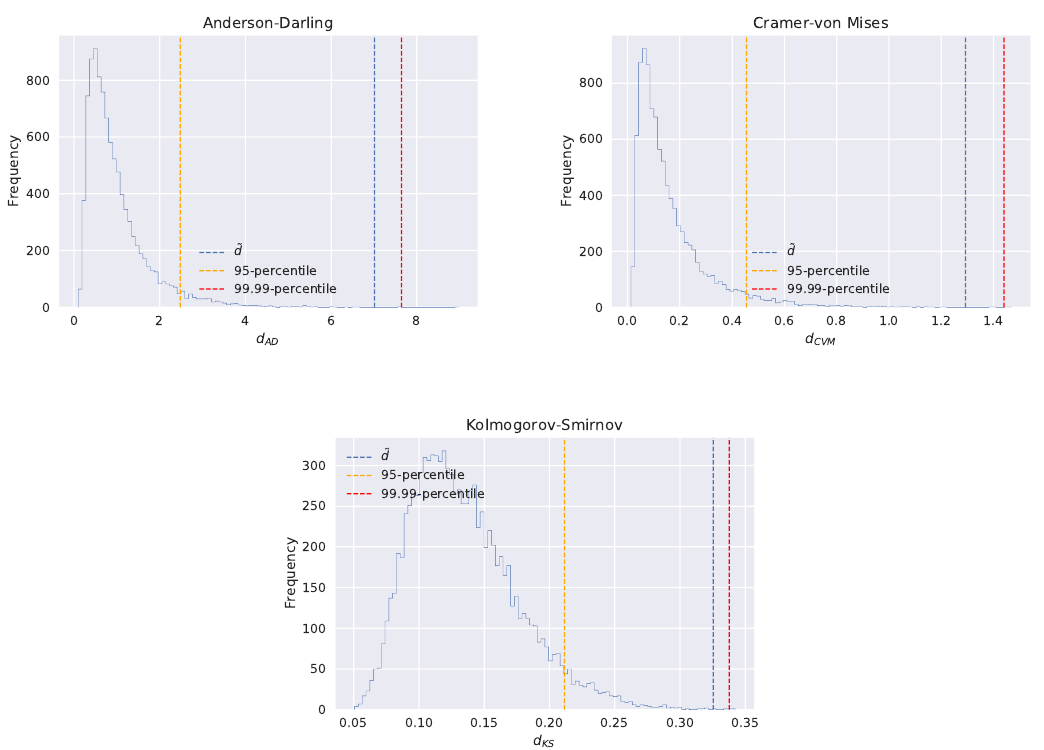
Figure 2. Examples of the three-color scoring scheme. The model in the example receives yellow scores for all three metrics, as d y < ˜ d < d r